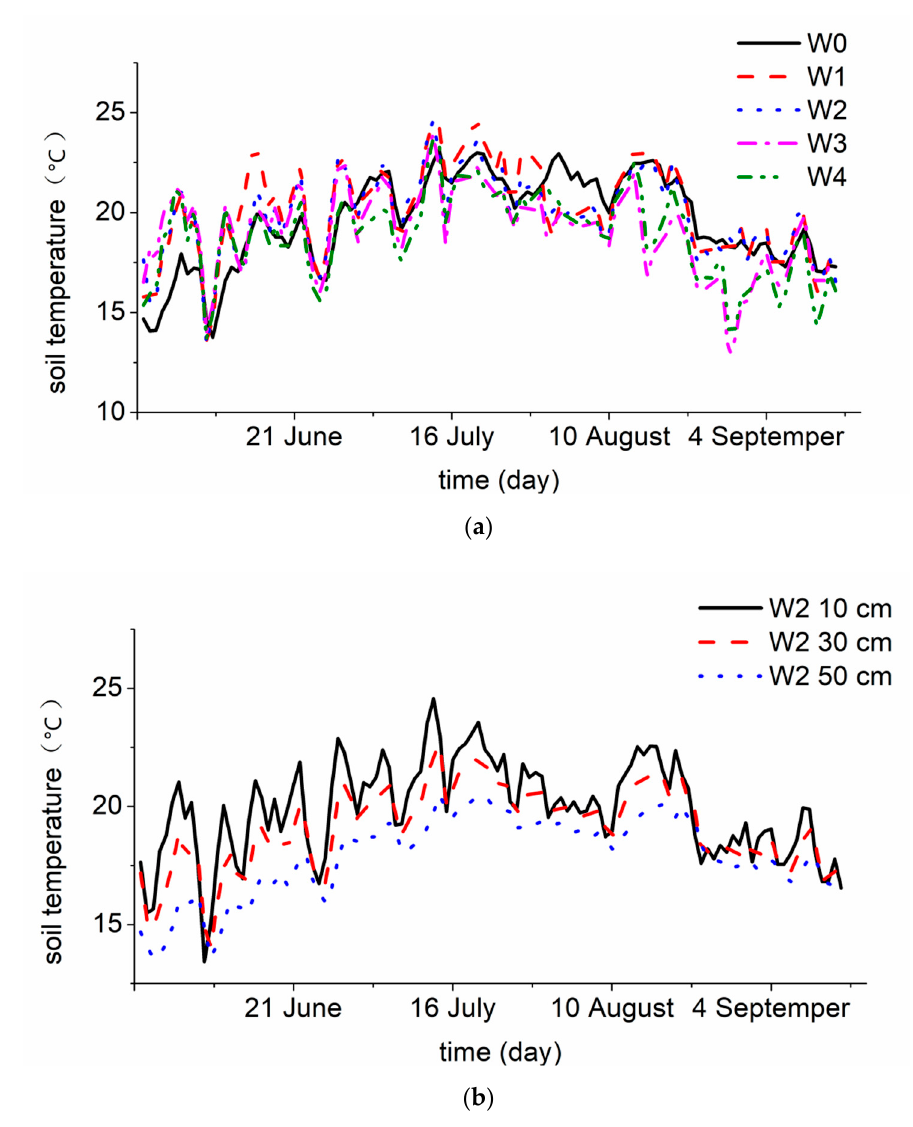
Figure 4. The variation of soil daily average temperature under ( a ) different treatments, and ( b ) different depths.